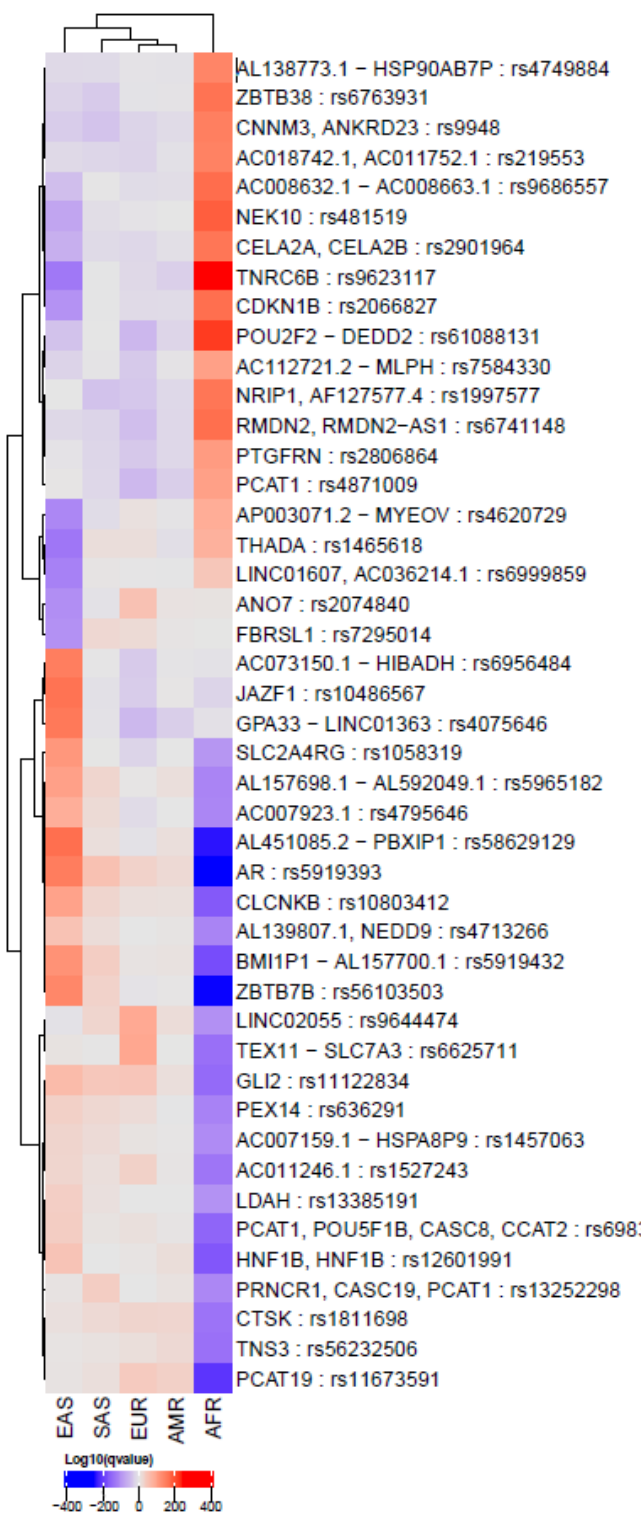
Figure 1. Heatmap showing log-adjusted p -value of Fisher’s exact test for significant single-nucleotide polymorphisms (SNPs) related to prostate cancer in global populations (AMR: American, EUR: European, SAS: South Asian, AFR: African, EAS: East Asian). Each row shows an SNP, and each column is a population group. The red color indicates enrichment of the allele, whereas the blue color indicates the depletion. The log-adjusted p -value of Fisher’s exact test in |AFR| + |EAS| > 100 for visibility.